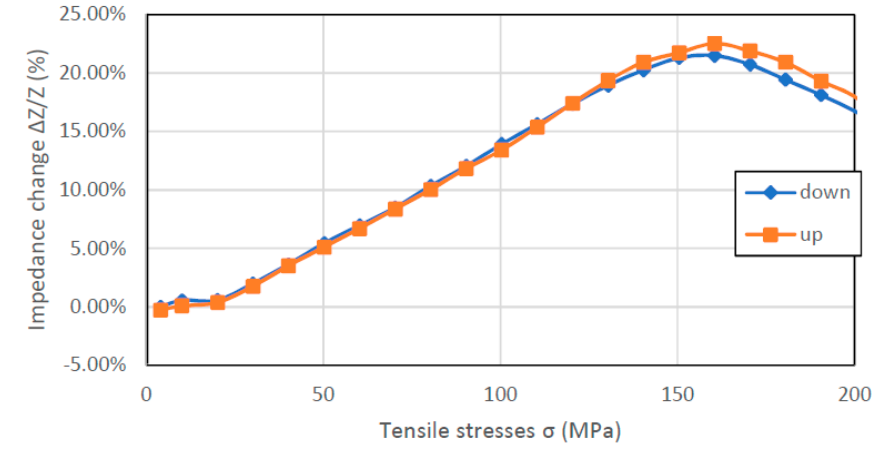
Figure 9. Hysteresis SI measurements of Co 84 Fe 1.5 Mo 2 Mn 1.5 Si 7 B 2 sample (for 1 MHz driving signal).